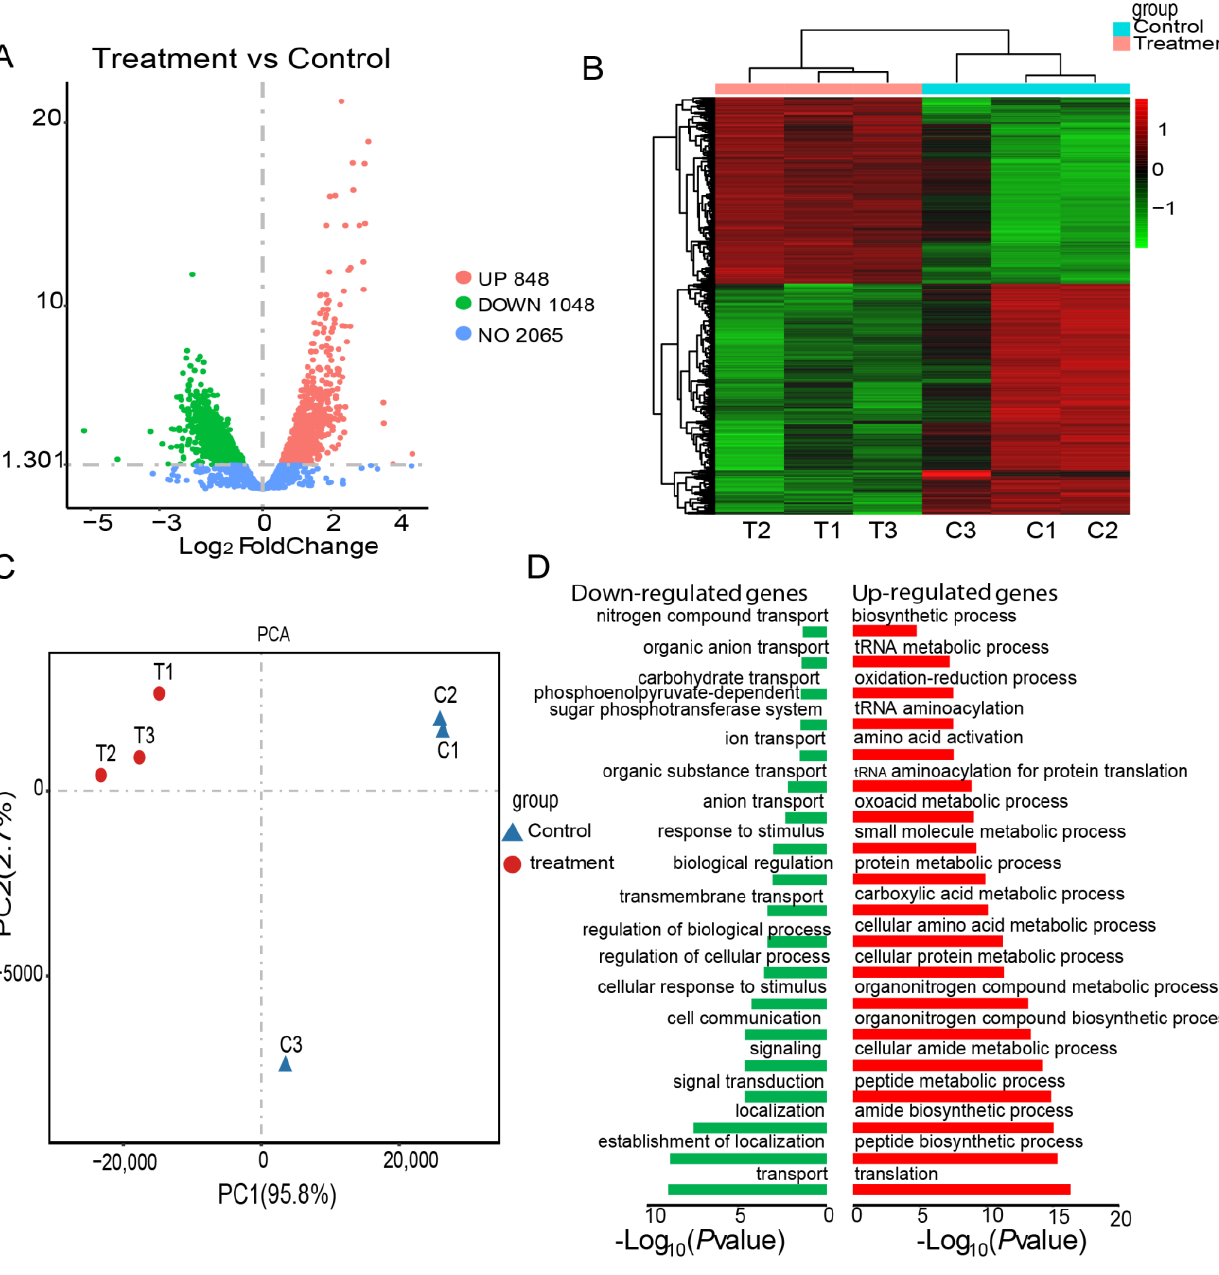
Figure 3. Transcriptome changes in A. hydrophila after umbelliferone treatment: ( A ) volcano plot of differentially expressed genes; ( B ) heatmap of the differentially expressed genes in A. hydrophila treated or untreated with umbelliferone; ( C ) PCA plot of differentially expressed genes. Control and umbelliferone treatment samples are shown in cyan and red, respectively; ( D ) functional enrichment analysis plot. Representative GO terms of up- and downregulated differentially expressed